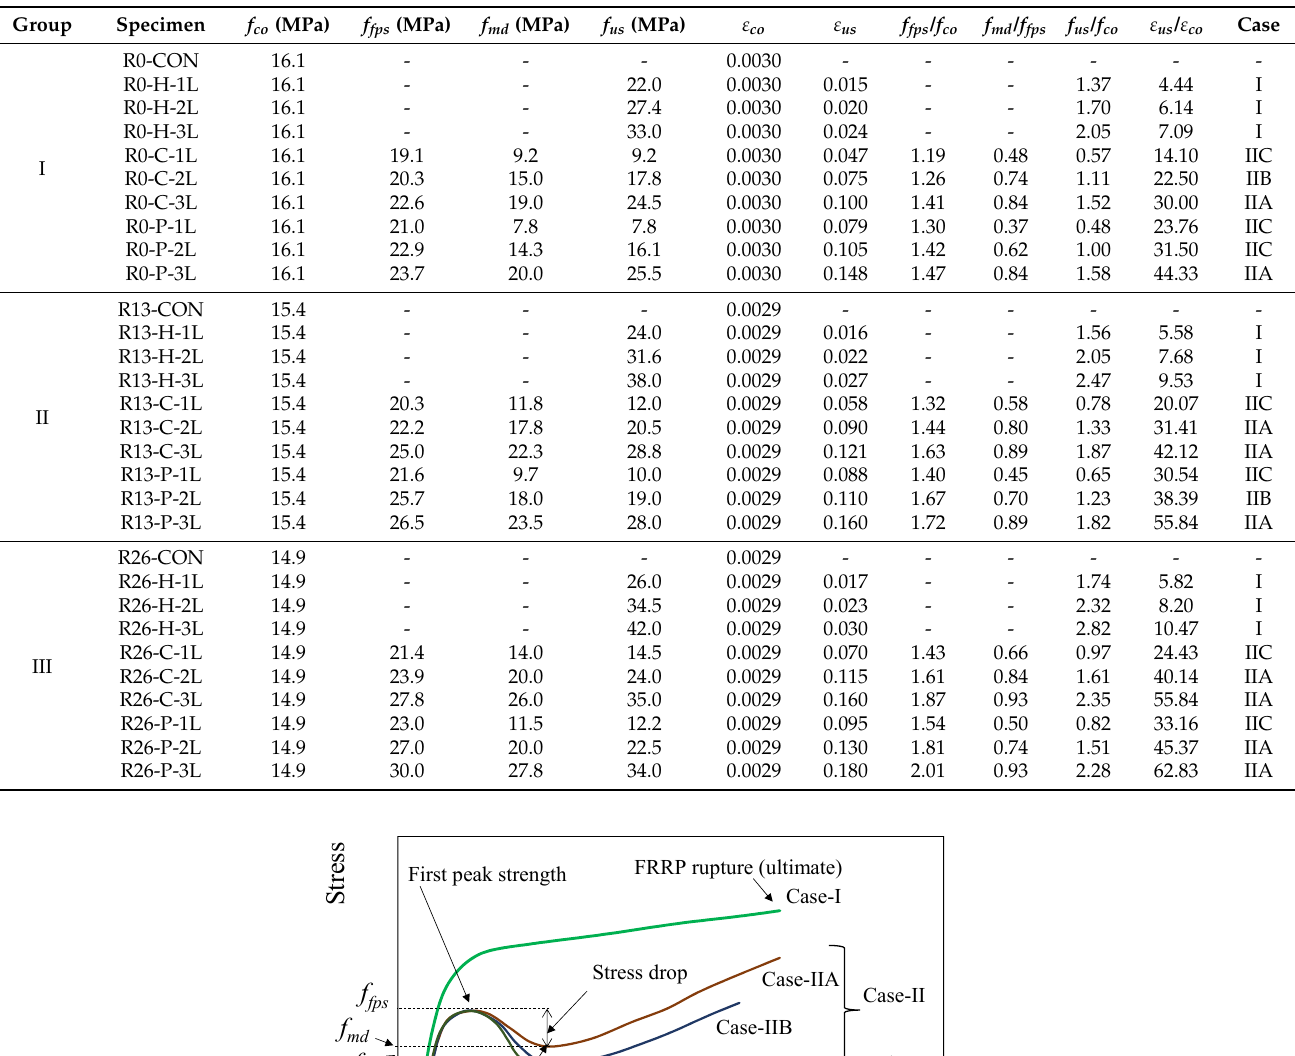
Table 2. Summary of experimental results.